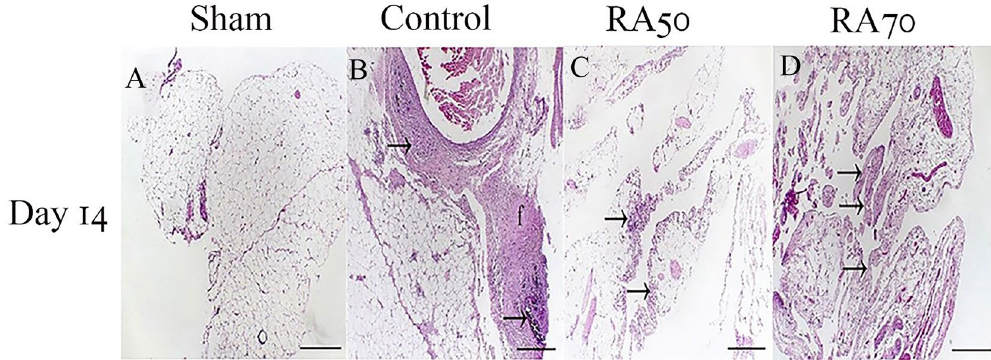
Figure 3. Visceral peritoneum; ( A ) Sham group. ( B ) Control group. Intensive granulomatous inflammation (arrows) and fibroblast proliferation (f). ( C ) Rosmarinic 50 group. Moderate inflammation of the peritoneum, which is mostly bordered at the margins (arrows). ( D ) Rosmarinic 70 group. Mild to moderate fibroblast proliferation with a low population of inflammatory cells throughout the lesion. A–D = 400